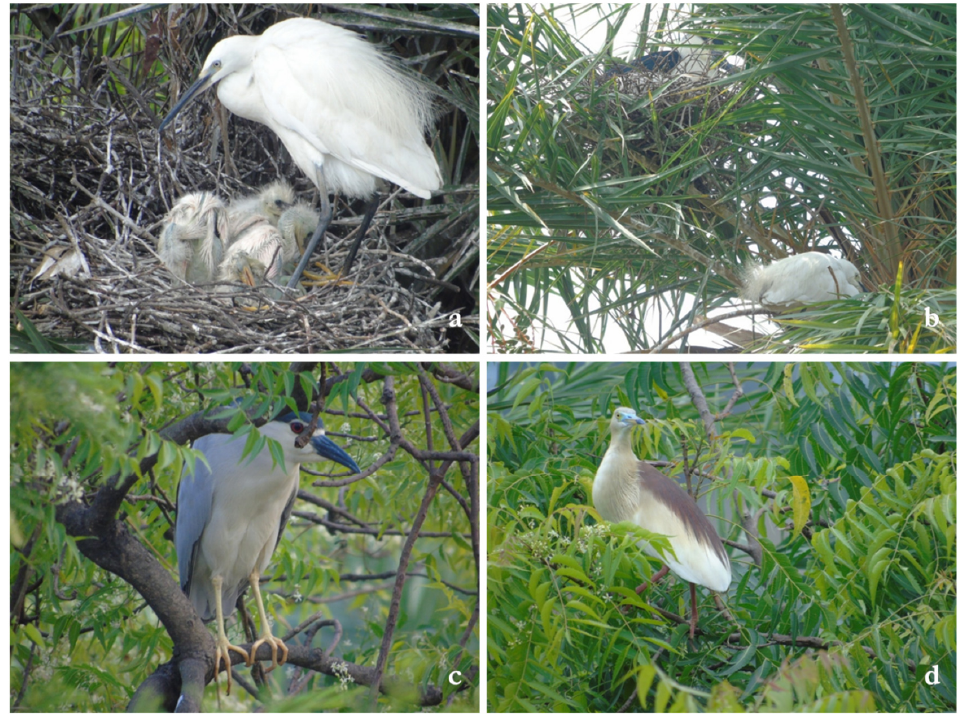
Figure 3. Three species of heronry birds surveyed in the study area 1. A little egret guarding the nest on an Indian date palm tree ( Phoenix sylvestris ); b. Nearest neighbours, above: A black-crowned night heron guarding the nest on a date palm tree, below: A little egret guarding the nest on the same tree; c. A black-crowned night heron sitting near the nest on a Neem tree ( Azadirachta indica ); d. An Indian pond-heron in breeding plumage sitting near the nest on a Neem